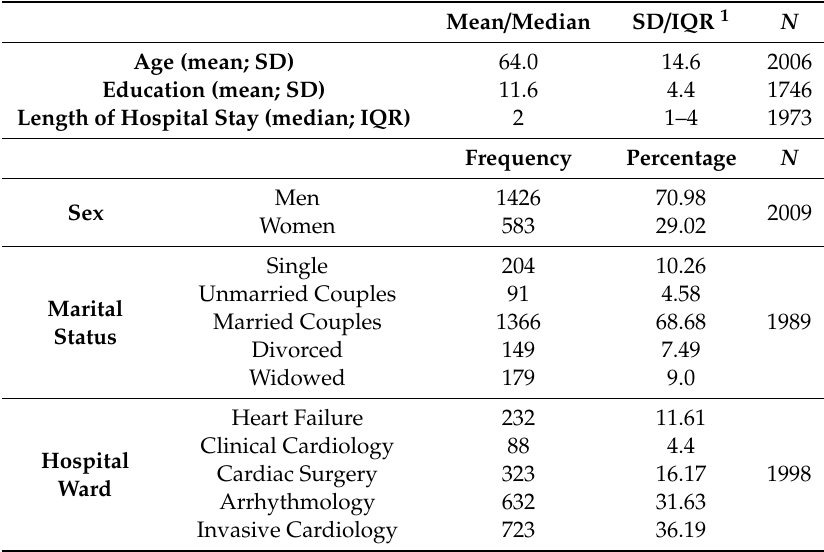
Table 1. Demographic and clinical characteristics of the sample.